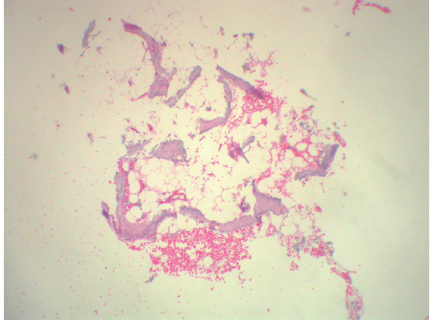
Figure 3: Mature bone fragment which became detached from the dermis during histologic processing, containing bone marrow (HE,